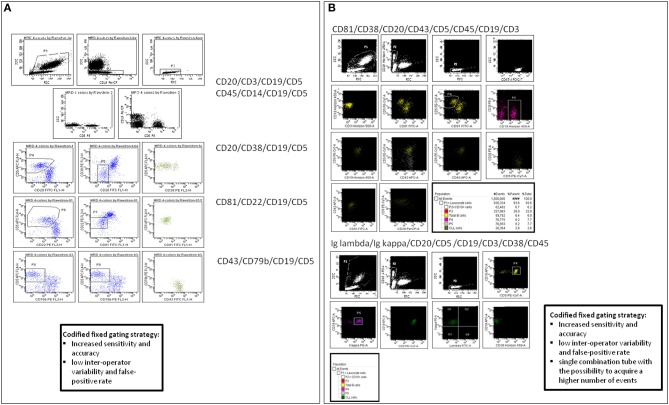
MRD analysis by flow cytometry (FCM). (A) ERIC standardized monoclonal antibodies combinations and analysis, according to Rawstron AC et al. (B) 8-colors panel designed in-house with a strategy of analysis based on the ERIC codified fixed gating.